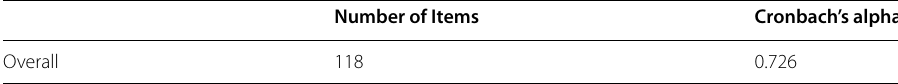
Table 2 Reliability of the first version of the questionnaire Number of